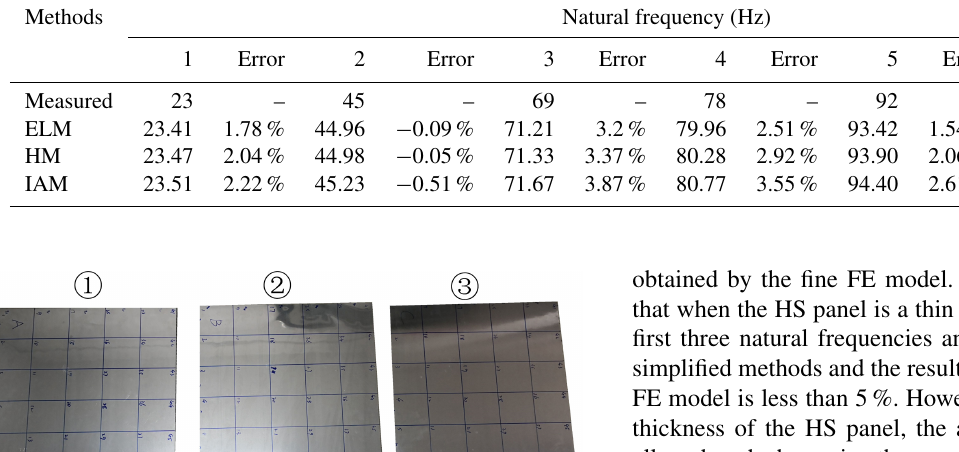
Table 6. Comparison of the first six natural frequencies of the honeycomb panel. Methods